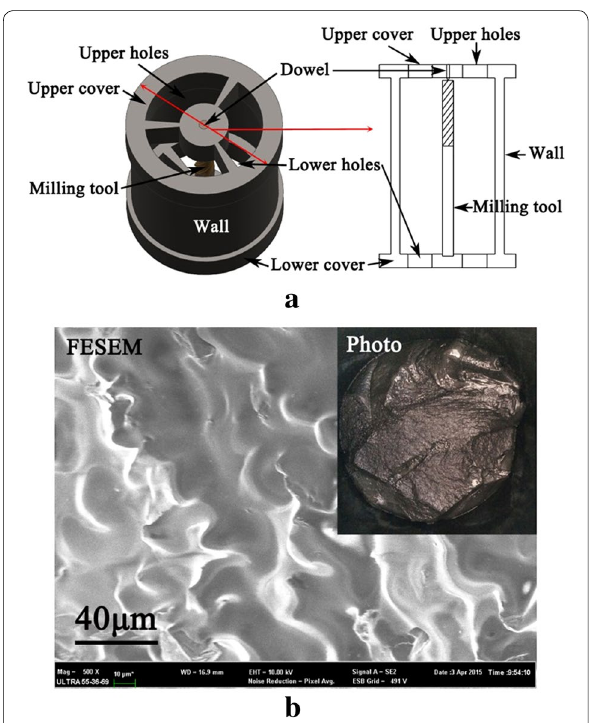
Figure 2 a As‑designed jig and b the special‑formulated polishing paste for abrasive flow machining the diamond coated milling